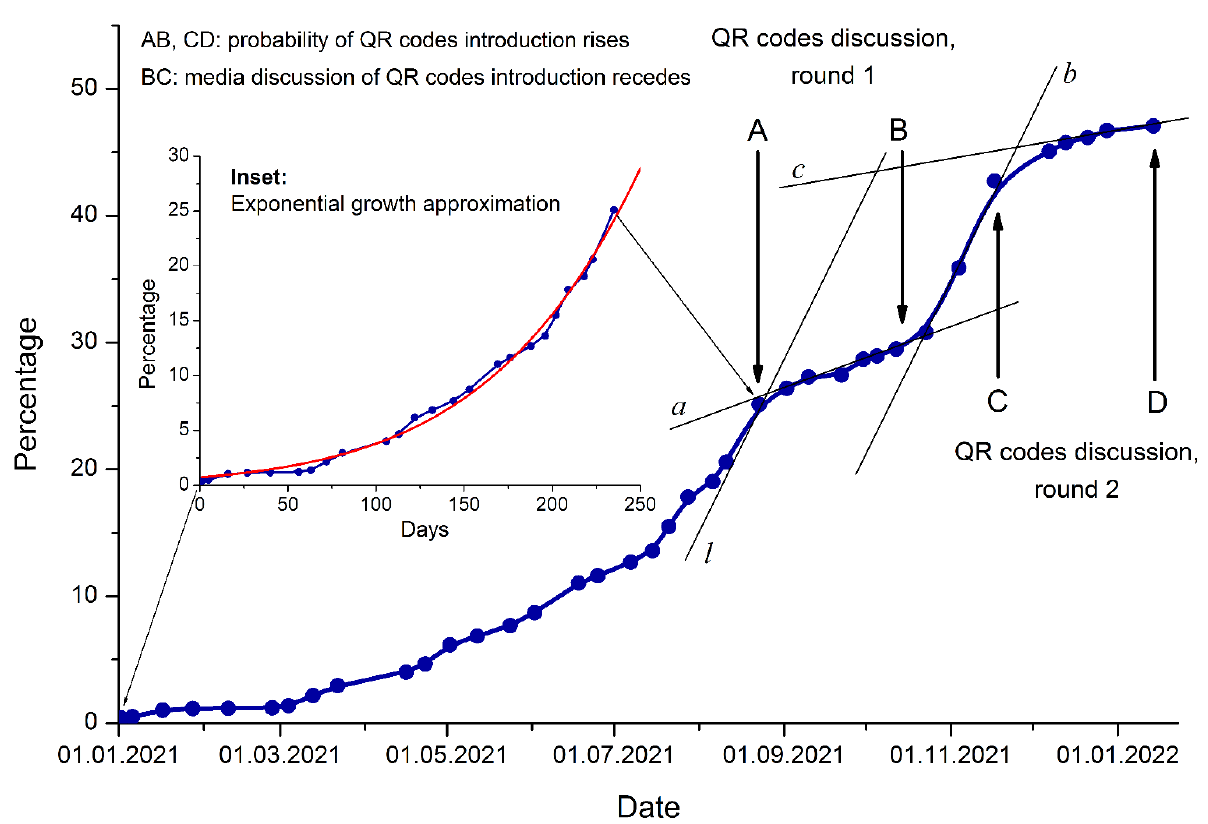
Figure 1. Anti-SARS-CoV-2 vaccination progression in Russia. Main figure: Percentage of the vaccinated Russian population (vaccination rate) since the beginning of 2021 thus far. The data are taken from the Gogov statistical agency [2]. Only fully vaccinated persons (at least two doses) are considered. Inset: Exponential growth approximation of the first segment OA (1 January 2021–23 August 2021) (red curve), with x -axis graduated in days since 1 January 2021. Two rounds of governmental discussion of the QR code program are shown as segments AB and CD. See the details and statistical treatment of the approximations in the text.